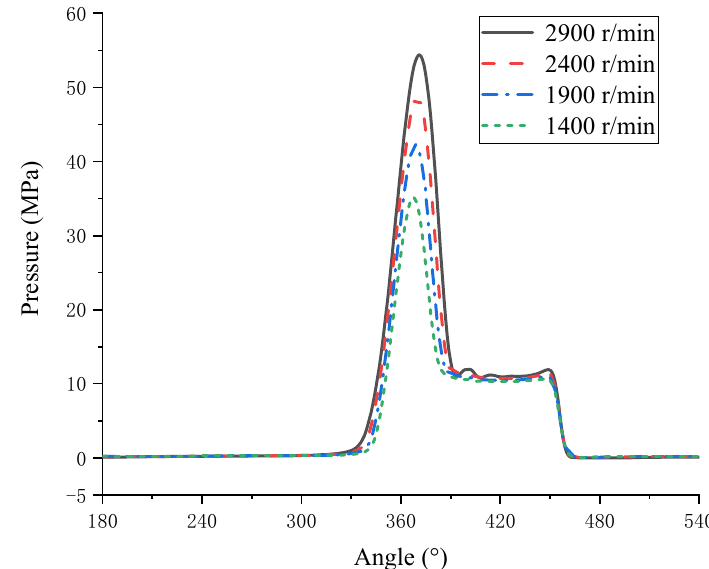
Figure 16. The pressure of P2 at different rotating speeds. Figure 17 shows the pressure of P2 at different axial clearances when the inlet pressure is 0.25 MPa, and the rotating speed is 2900 r/min. It can be seen that with the increase in the axial clearance between the upper and lower scrolls, the maximum pressure in the working chamber visibly decreases. In the range of pressure pulsation angle, the leakage through the two axial clearances would increase, resulting in the working chamber releasing pressure in time.